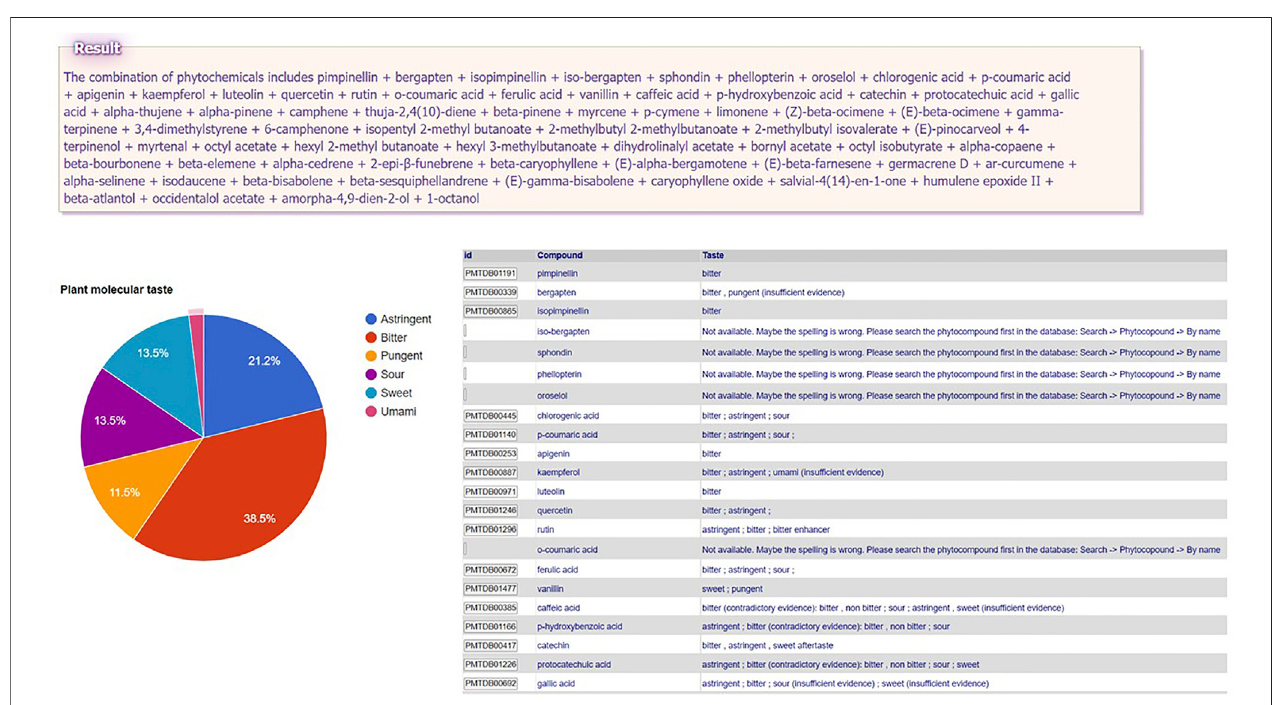
FIGURE 1 | Plant Molecular Taste of small hogweed ( Heracleum sphondylium L ., Apiaceae family) generated in PlantMolecularTasteDB.